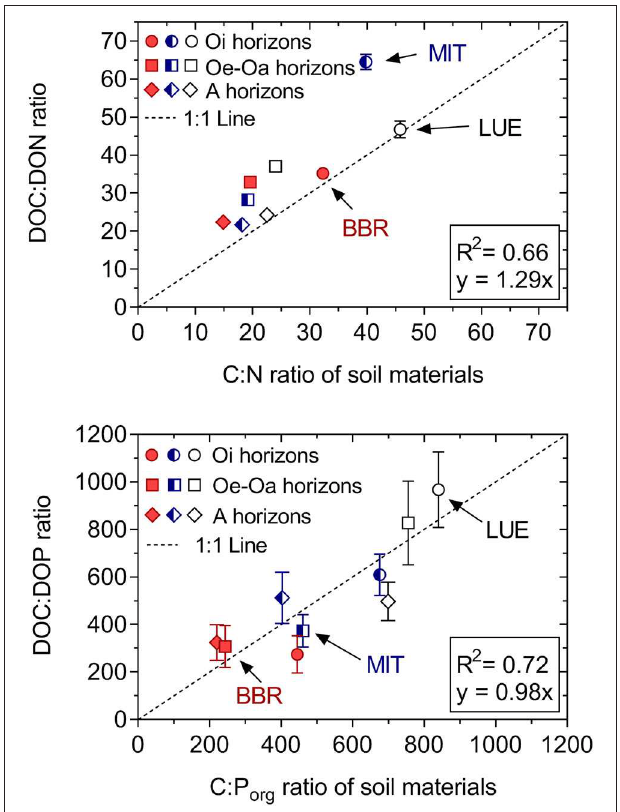
FIGURE 5 | Ratio of mobilized DOC:DON and DOC:DOP (averaged over 33 weeks) related to C:N and C:P org ratios of initial soil materials for the permanent moist control treatment. While DOC:DON ratios are greater than soil C:N ratios, the DOC:DOP ratios and soil C:P org ratios are similar. Means and standard errors of four